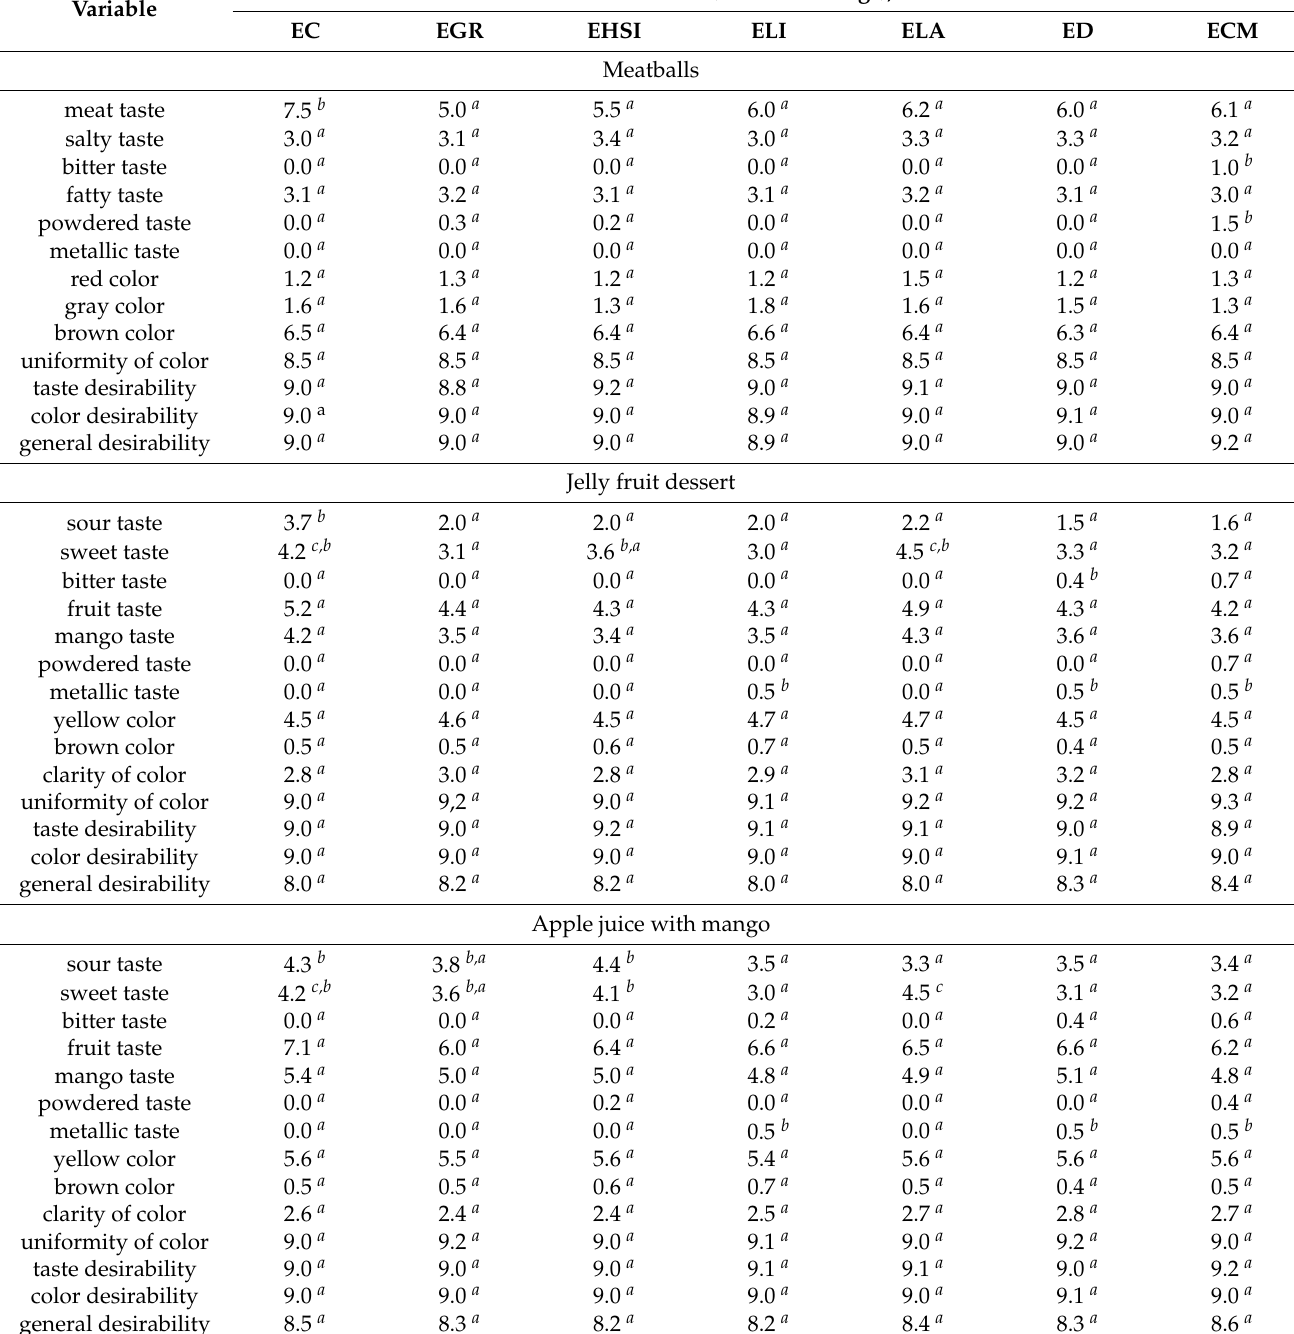
Table 3. Characteristics of sensory taste profiling and consumer analysis of meatballs, jelly fruit dessert and apple juice with